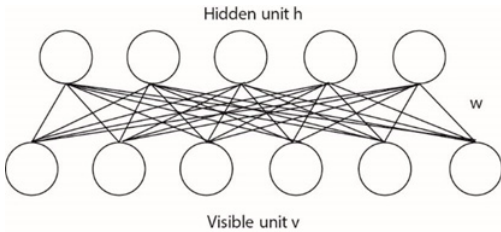
Figure 1. Schematic illustration of a restricted Boltzmann machine (RBM).